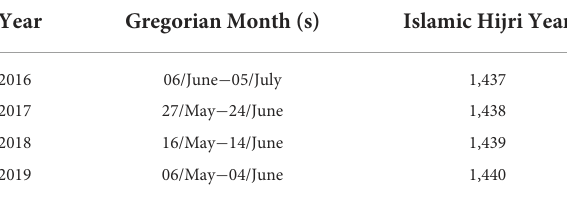
TABLE 1 The Gregorian months corresponding to the Islamic Hijri month